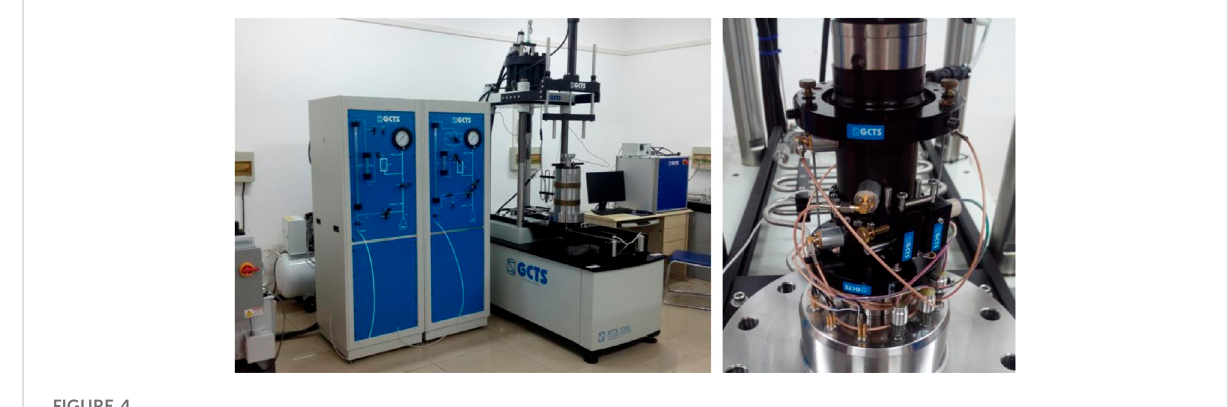
FIGURE 4 The GCTS Triaxial test